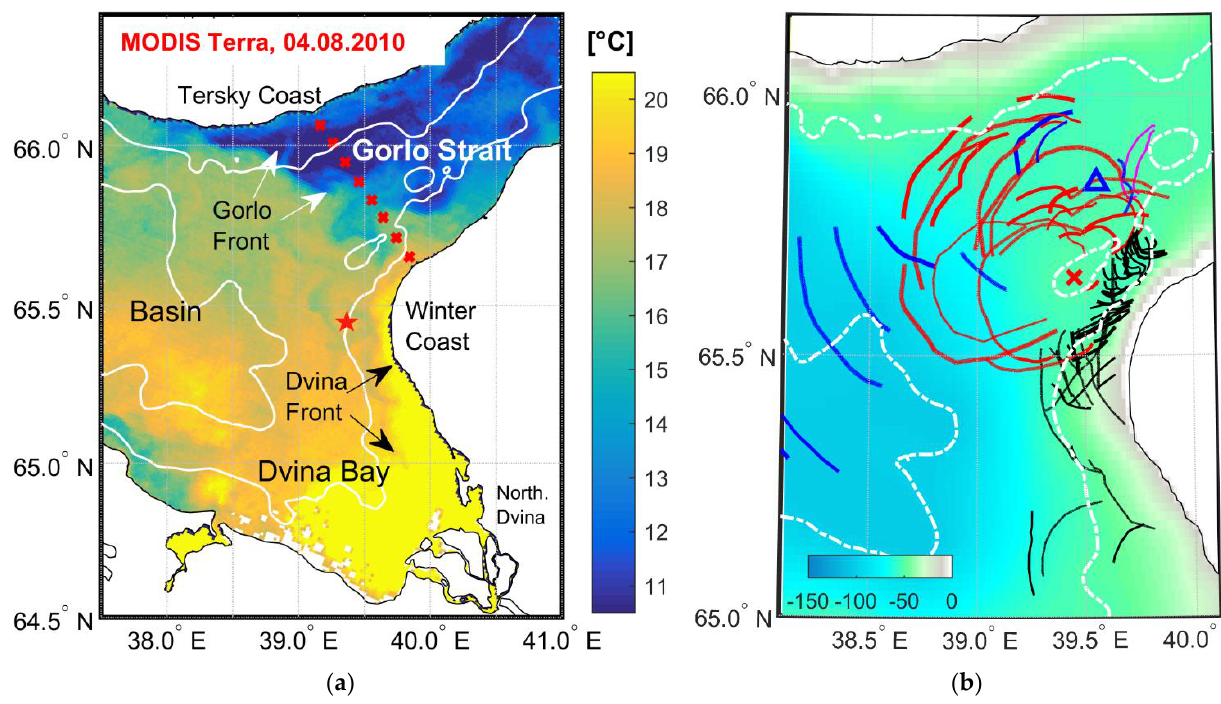
Figure 10. ( a ) MODIS Terra SST map acquired on 4 August 2010 over the eastern part of the White Sea, showing two major fronts formed by the Barents Sea water entering through the Gorlo Strait and the Northern Dvina River outflow to the Dvina Bay. Red crosses and red star show locations of the transect crossing the GS and polygon 7, respectively. ( b ) Locations of ISW crests detected on 29 July–5 August 2012 in Radarsat-1/-2 data; red curves show ISW signatures detected on 29 July 2012 (see Figure 10). Red cross and blue triangle mark underwater banks in the GS. Solid and dashed white lines in ( a , b ) show 50 m and 100 m isobaths from IBCAO v.3